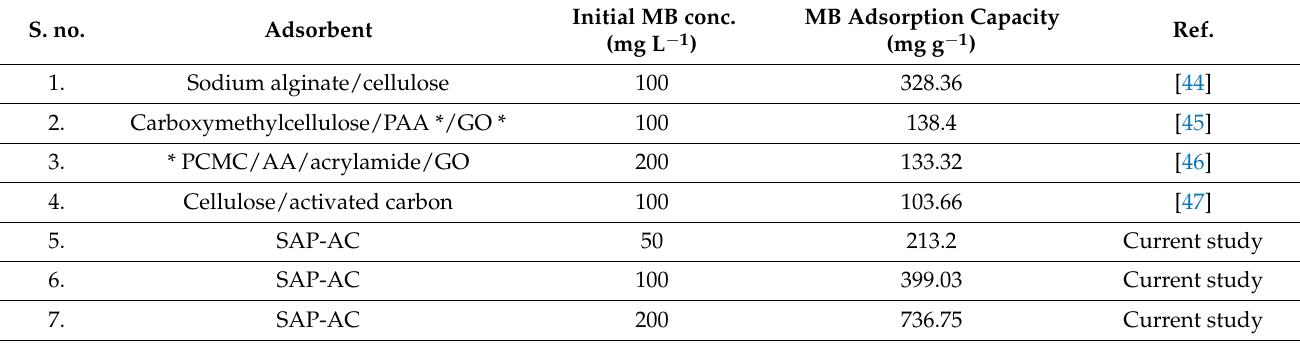
Table 2. Comparison of MB adsorption capacities on different